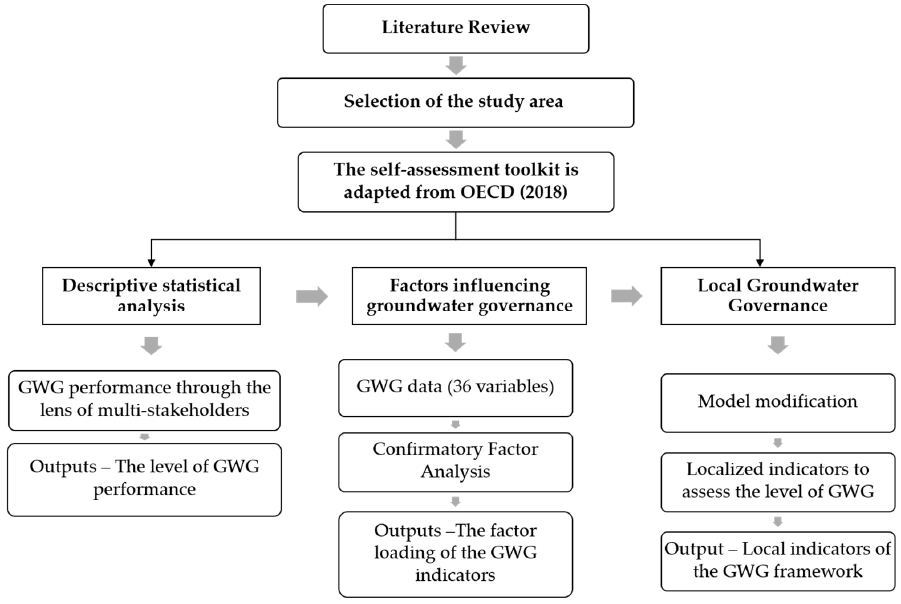
Figure 2. Data and method for the adopted methodology.